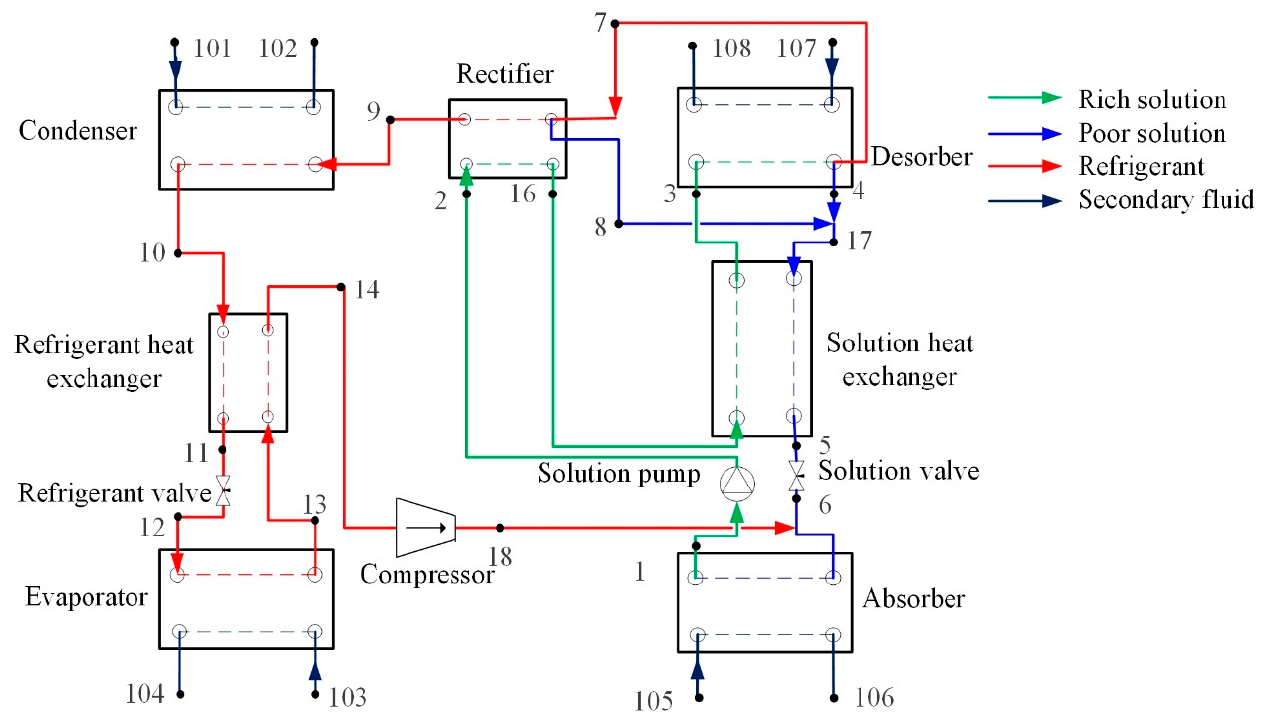
Figure 2. Flow diagram of compression-assisted ammonia/water absorption cycle.